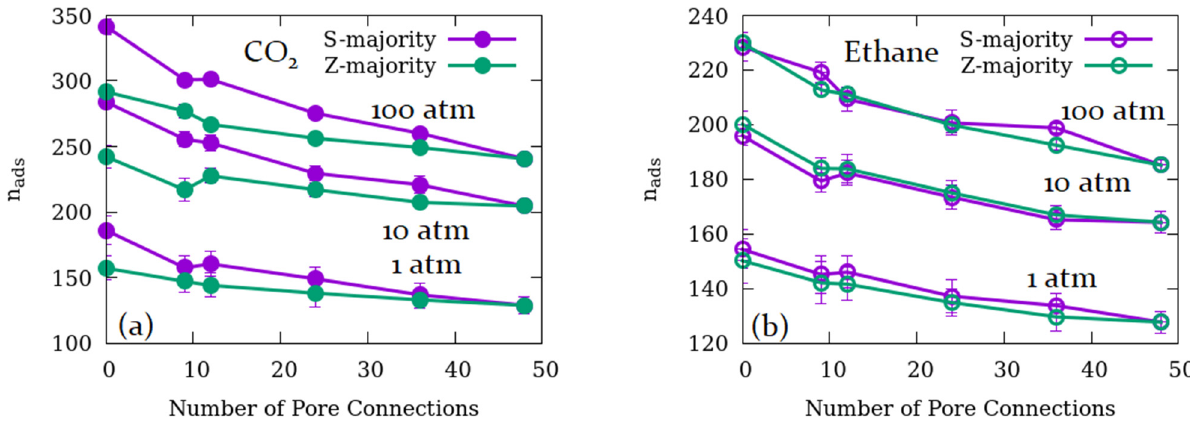
Figure 6. Amount of fluid adsorbed, ( a ) CO 2 and ( b ) ethane, normalized to the pore volume available in the unmodified silicalite (S4Z4) as a function of the number of pore connections. Bars on symbols signify the extent of uncertainty in the calculations.